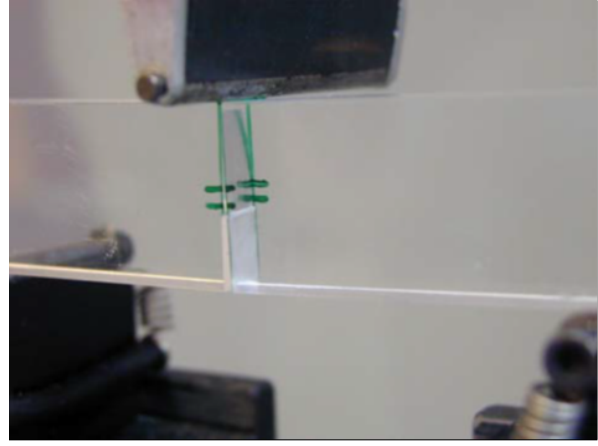
Figure 4. Three point bending test during crack propagation